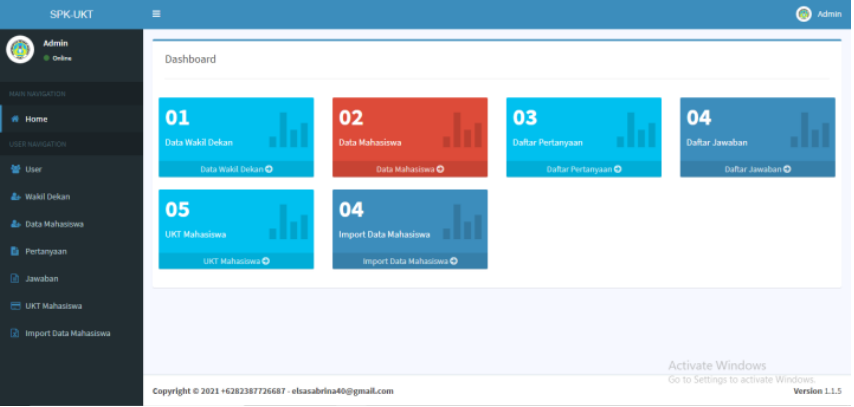
Figure 7. Admin Main Page